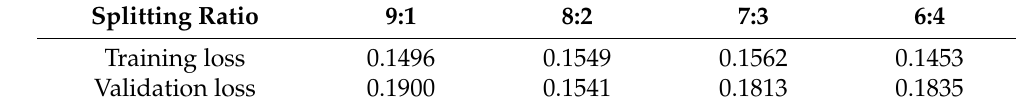
Table 2. Losses of the training set and validation set under different splitting ratios. The setting of the seq2seq model is presented in Section 4.